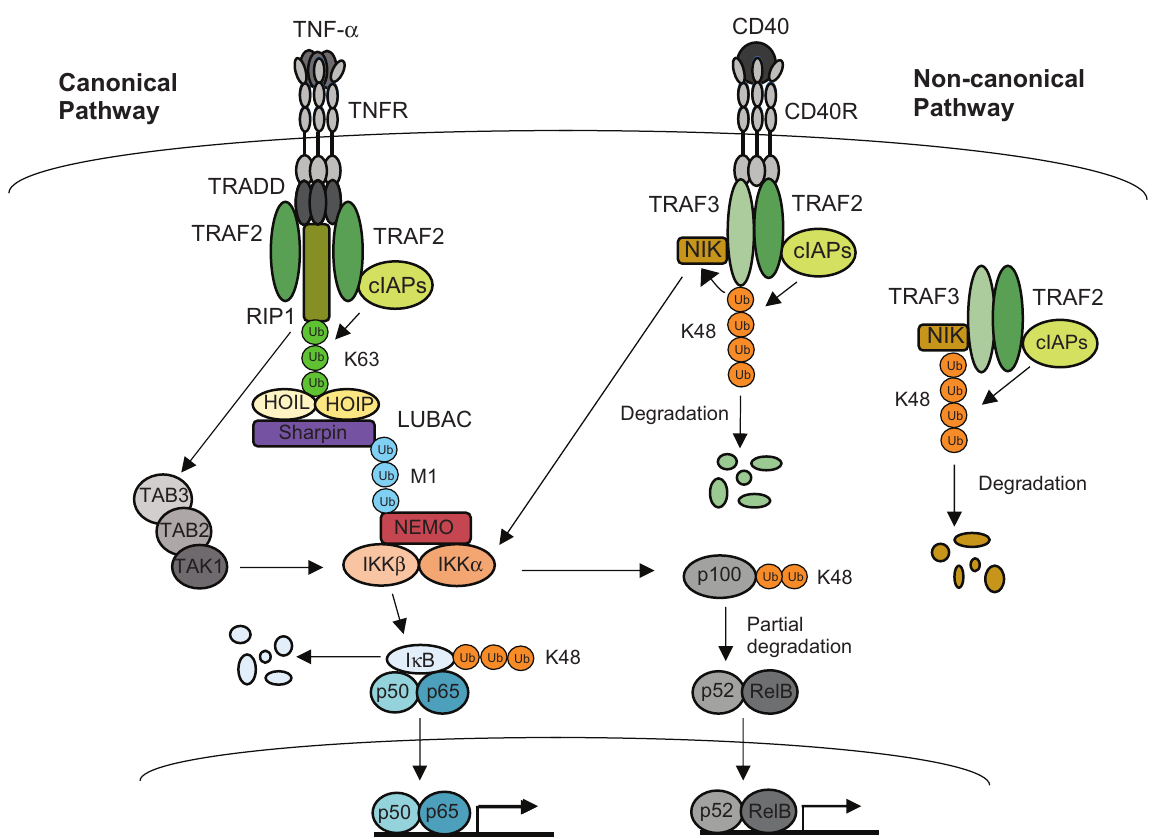
Figure 4. Ubiquitination-mediated signaling cascades in canonical and non-canonical NF-(cid:2)B pathways. In canonical pathway, binding of TNF-(cid:3) to TNFR1 triggers recruitment of